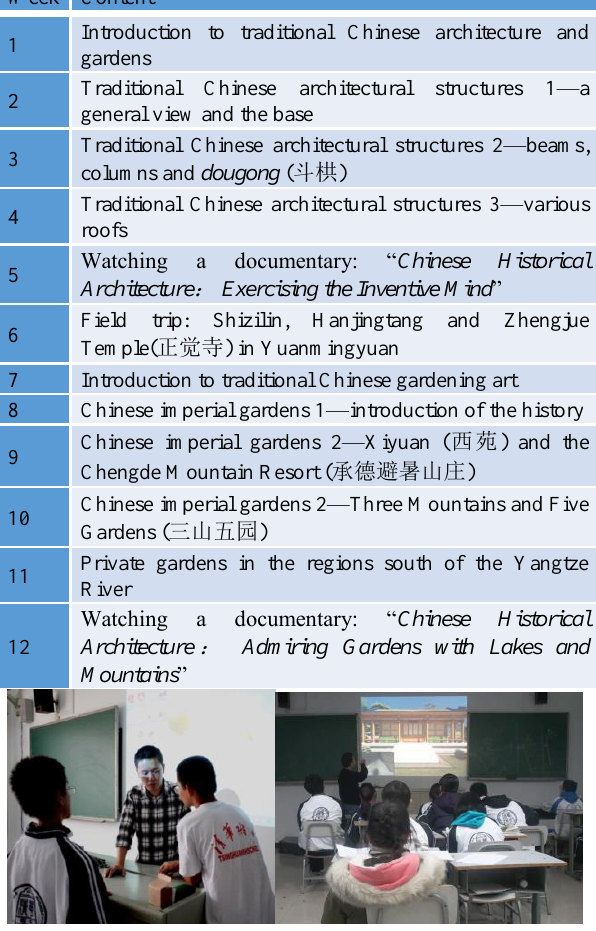
Figure 2. Students doing and presenting various research projects